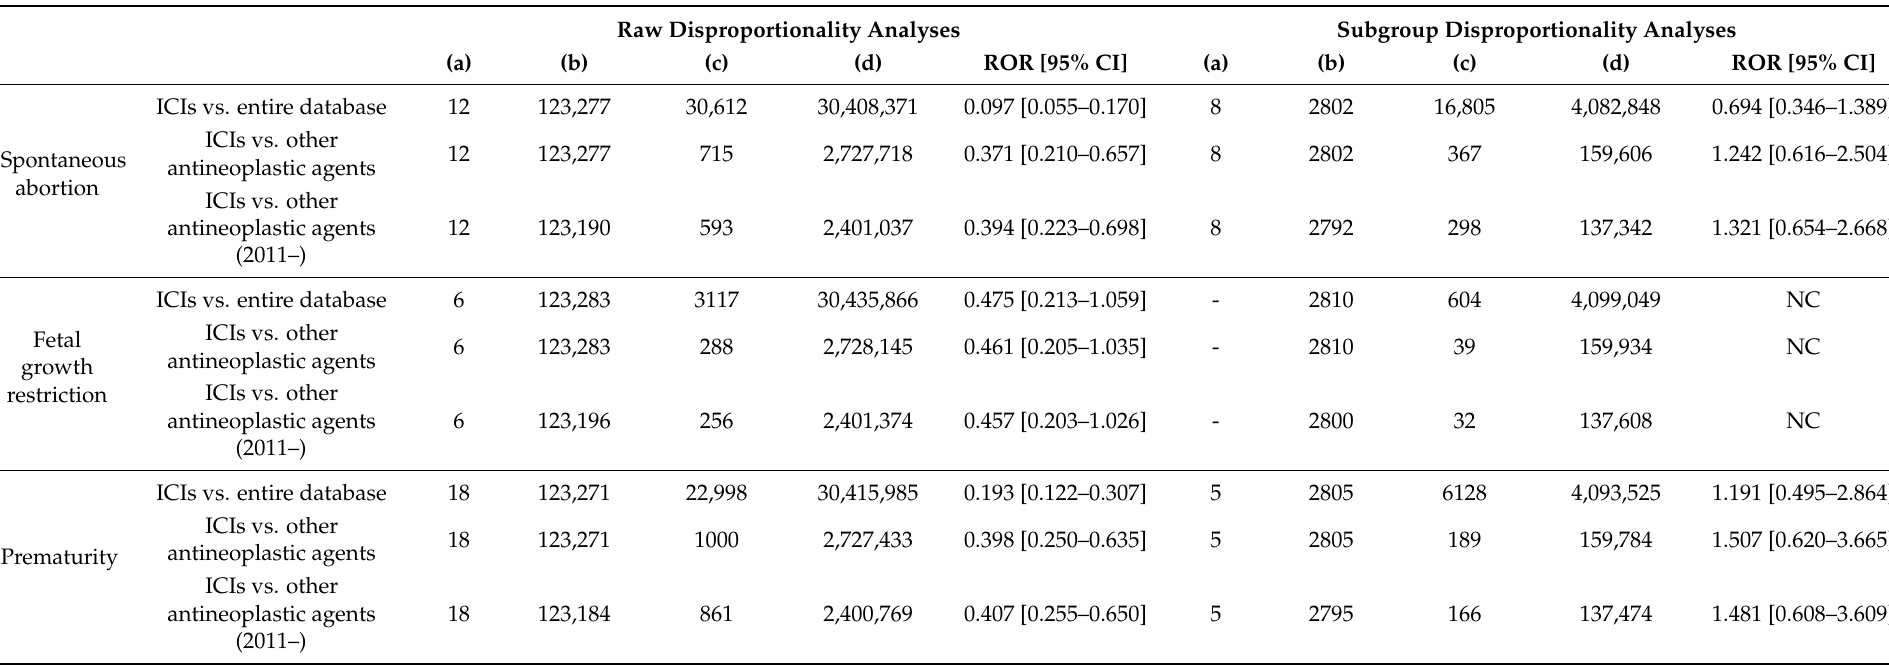
Table 3. Computation of reporting odds ratios and 95% confidence intervals in raw and subgroup (by sex and age, females aged 20–44 years) disproportionality analyses. Raw Disproportionality